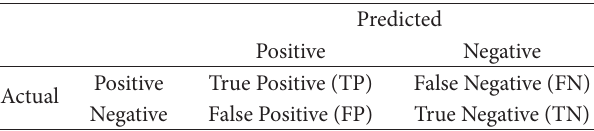
Table 2: Confusion